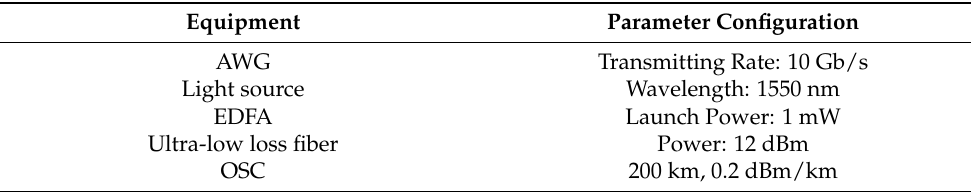
Table 1. Simulation parameter list.